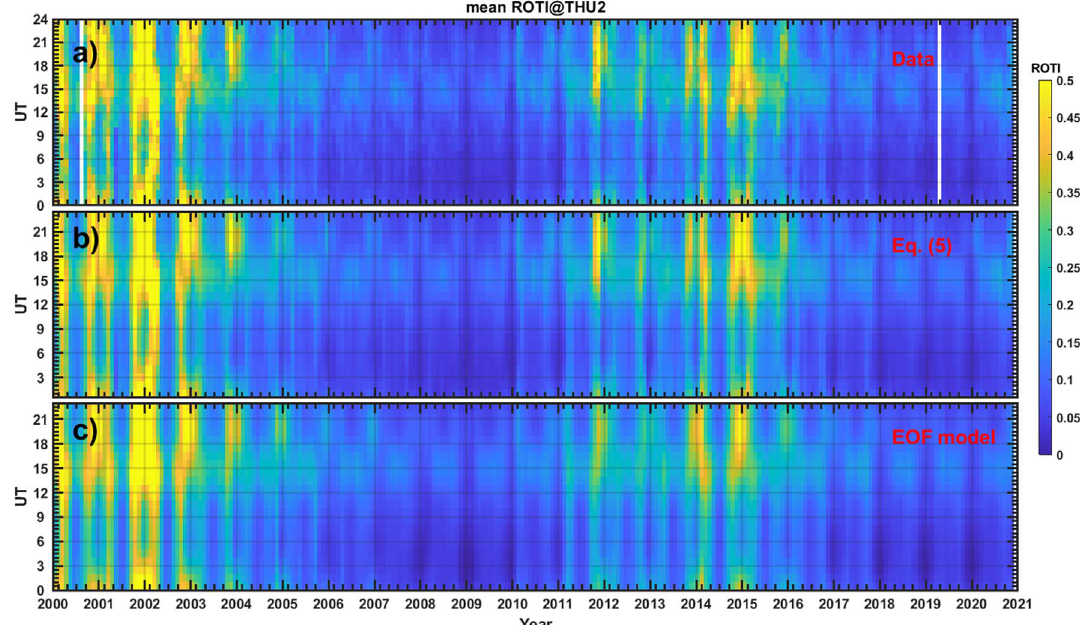
Fig. 7. (a) The climatology of ROTI from the Thule station; (b) the reconstructed ROTI climatology using equation (5); (c) the reconstructed ROTI climatology using the EOF model using the geophysical parameters as